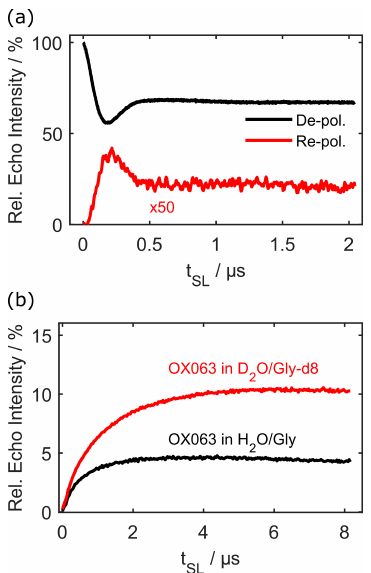
Figure 4. Electron inversion recovery (a) , and decay of nuclear po- larisation (b) at 50 and 80K for 100µM OX063. T 1 , e is unaffected by deuteration of the